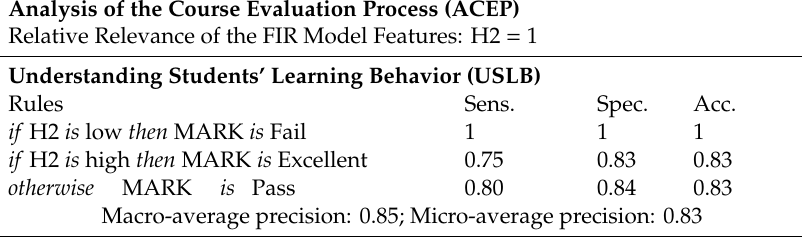
Table 8. ACEP, USLB, ASLP, and GSLB toolbox results for the model 2 of the introductory course. The MARK variable was discretized into three classes: fail (from 0–60), pass (from 61–80), and excellent (from 81–100). H2 was also discretized into three classes: low (from 0–6), medium (from 6.1–8.9), and high (from 9–10). Spec., Sen., and Acc. stand for specificity, sensitivity, and accuracy,